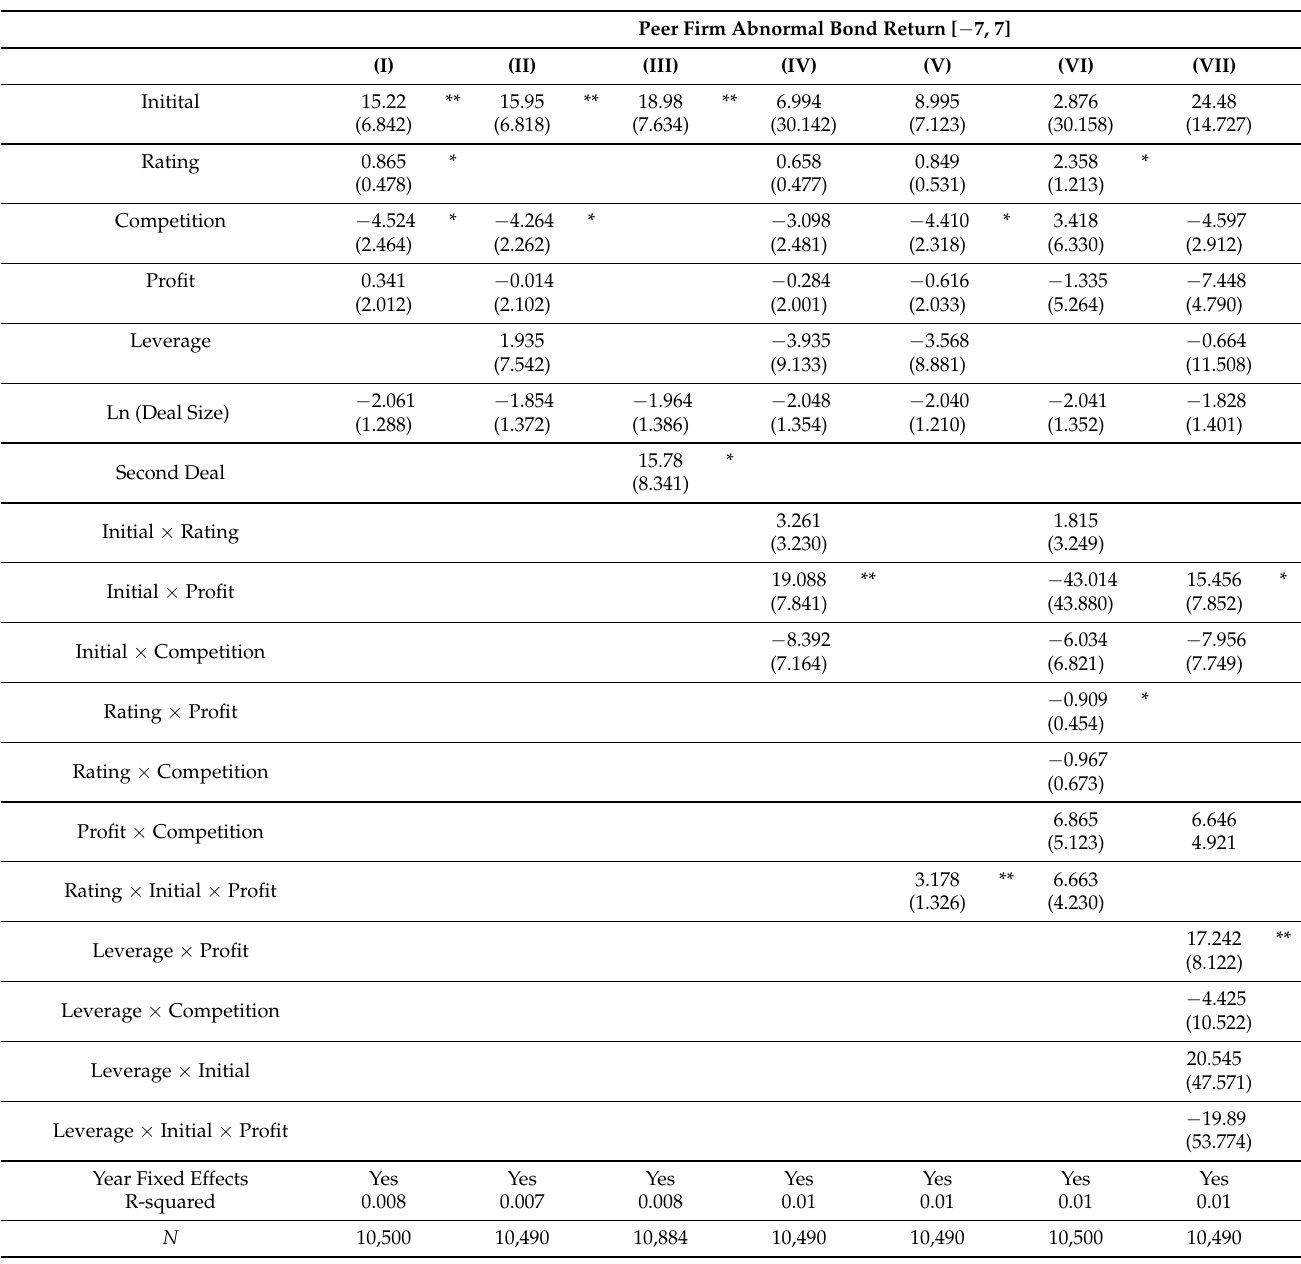
Table 5. Between Firms Multivariate Regression